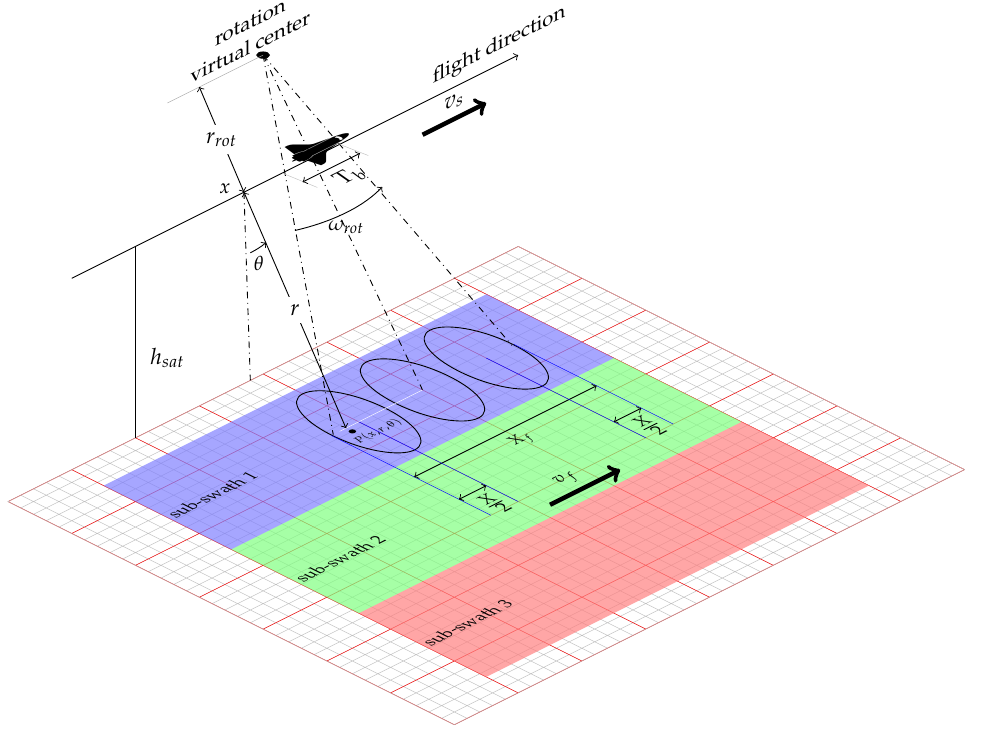
Figure 2. TOPS acquisition geometry for a single burst: P ≡ P ( x , r , θ ) represents the location of a generic target, v s is the sensor velocity, v f the antenna footprint velocity, ω rot the angular rotation velocity, r rot the distance of the SAR sensor flight track from the virtual rotation center, T b the acquisition burst time, X f the illuminated area extension on the ground, X the azimuth antenna